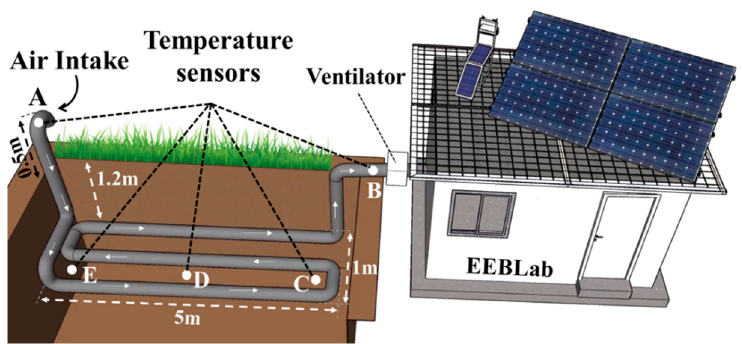
Figure 14. EAHE prototype measurements and sensors placement.